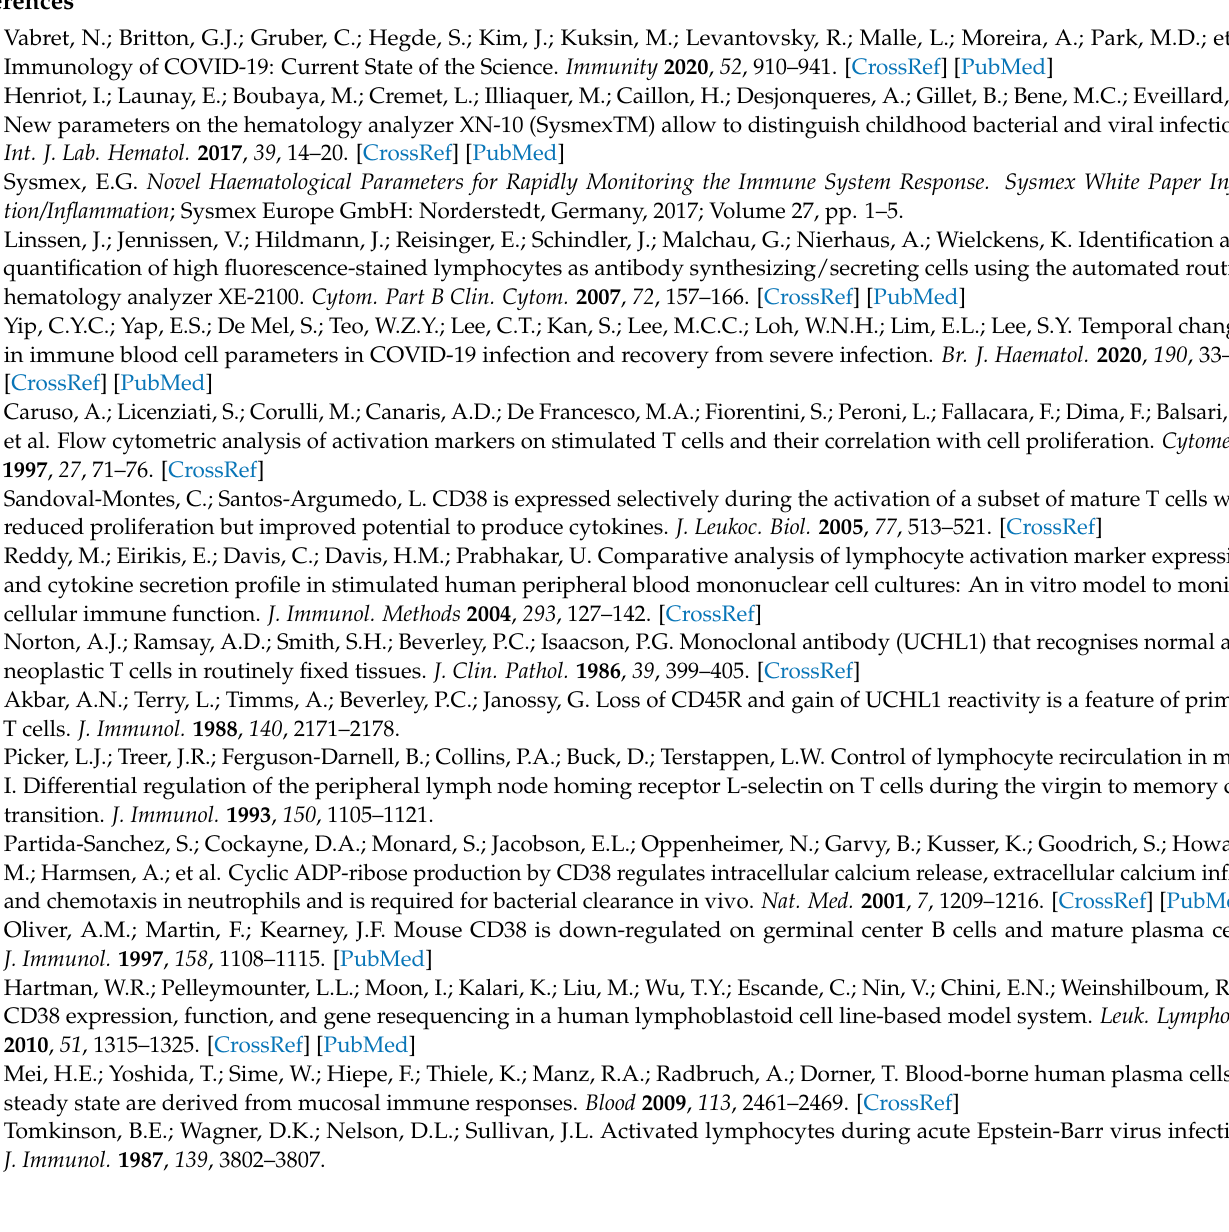
CD45 vs. SSC-A plot: Selection of lymphocytes based on their SSC/CD45+ properties, CD19 vs. SSC-A plot: Selection of lymphocytes B (blue) based on their SSC/CD19+ properties, CD19 vs. CD38 plot: Selection of plasmablasts (red) based on their CD19/CD38 properties (CD19+ and CD38+high). ( B ) T lymphocyte gating strategy: FSC-A vs. FSC-H plot: Gating the cells that have an equal area and height, thus removing clumps (greater FSC-A relative to FSC-H) and debris (very low FSC), CD45 vs. SSC-A plot: Selection of lymphocytes based on their SSC/CD45+ properties, CD3 vs. SSC-A plot: Selection of lymphocytes T based on their SSC/CD3+ properties, CD8 vs. CD4 plot: Selection of T lymphocyte subpopulation: CD4+ (pink) and CD8+ (green) based on their CD4/CD8 properties. ( C ) Representative plots with CD25 proportion and CD25 geometric mean fluorescence (GMF) intensity on CD4+ and CD8+ T lymphocyte subpopulation. ( D ) Representative plots with CD45RO proportion and CD45RO GMF intensity on CD4+ and CD8+ T lymphocyte subpopulation. ( E ) Representative plots with HLA-DR proportion and HLA-DR GMF intensity on CD4+ and CD8+ T lymphocyte subpopulation. ( F ) Representative plots with CD38 proportion and CD38 GMF intensity on CD4+ and CD8+ T lymphocyte